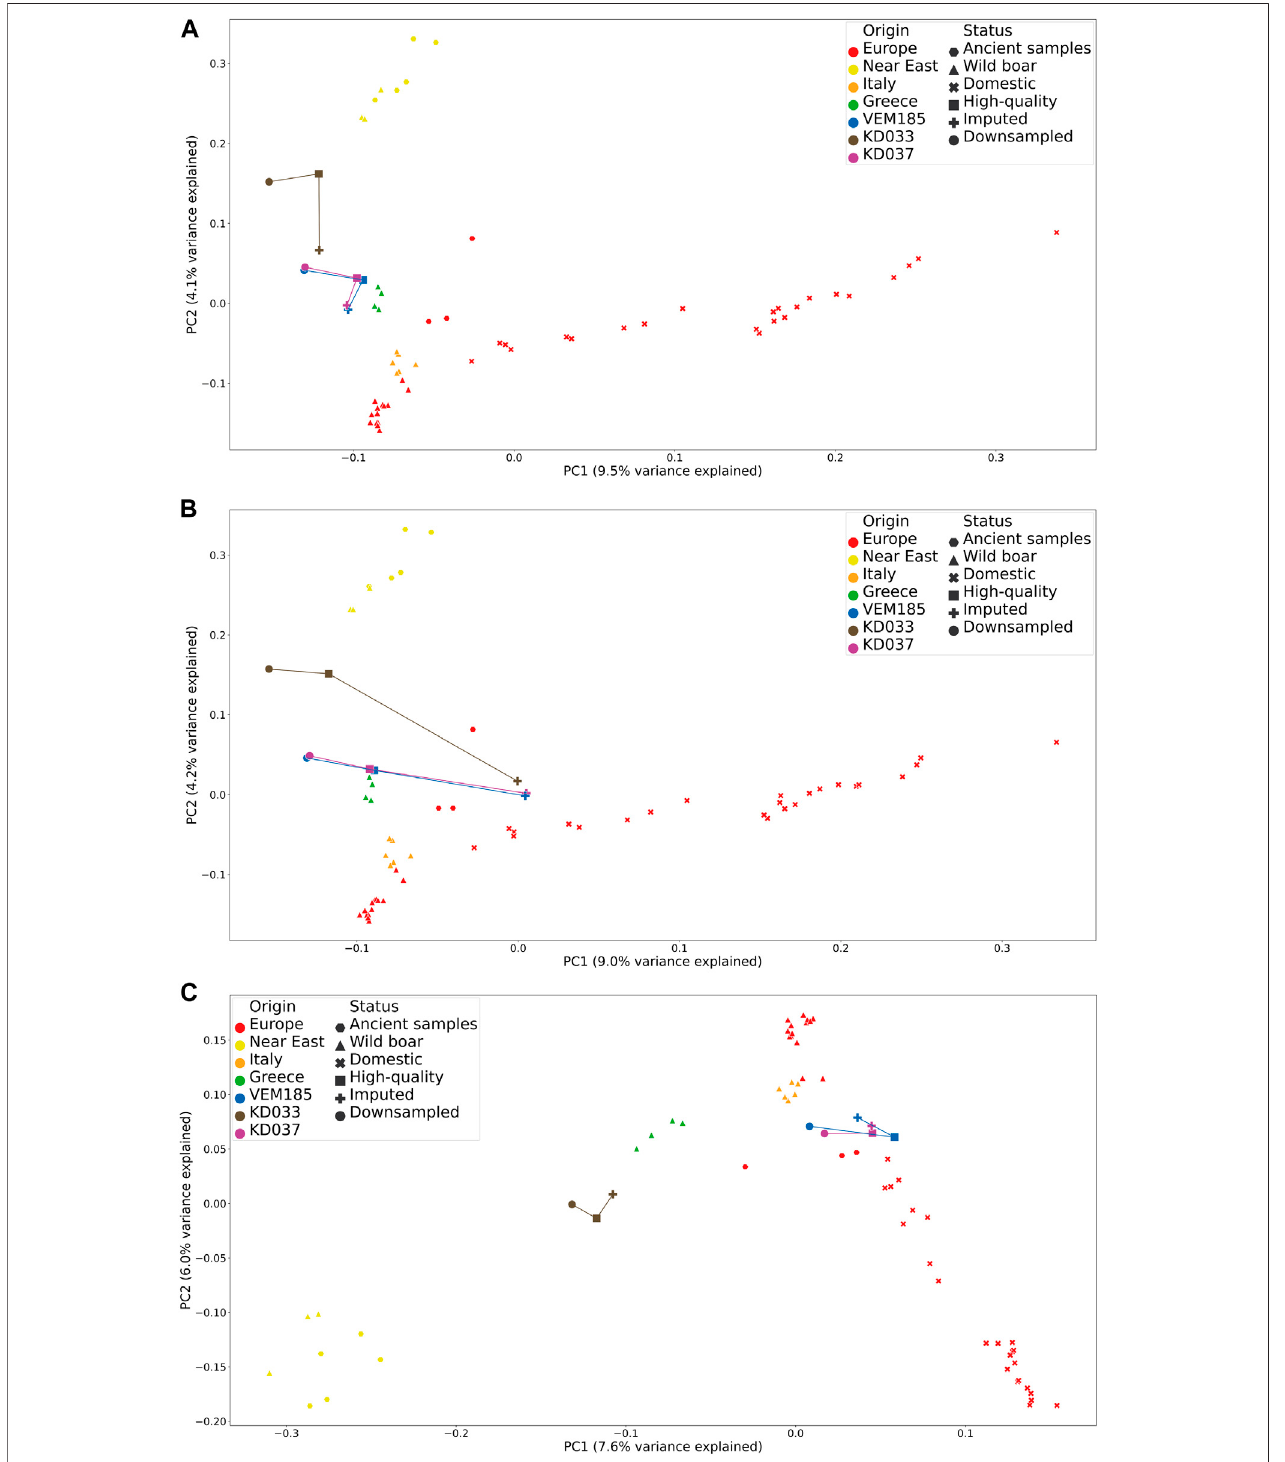
FIGURE 2 | Principal component analysis comparing high-quality, imputed genotypes and downsampled data together with samples from the reference panel. IMP1 (A) , IMP4 (B) , and IMP5 (C) .